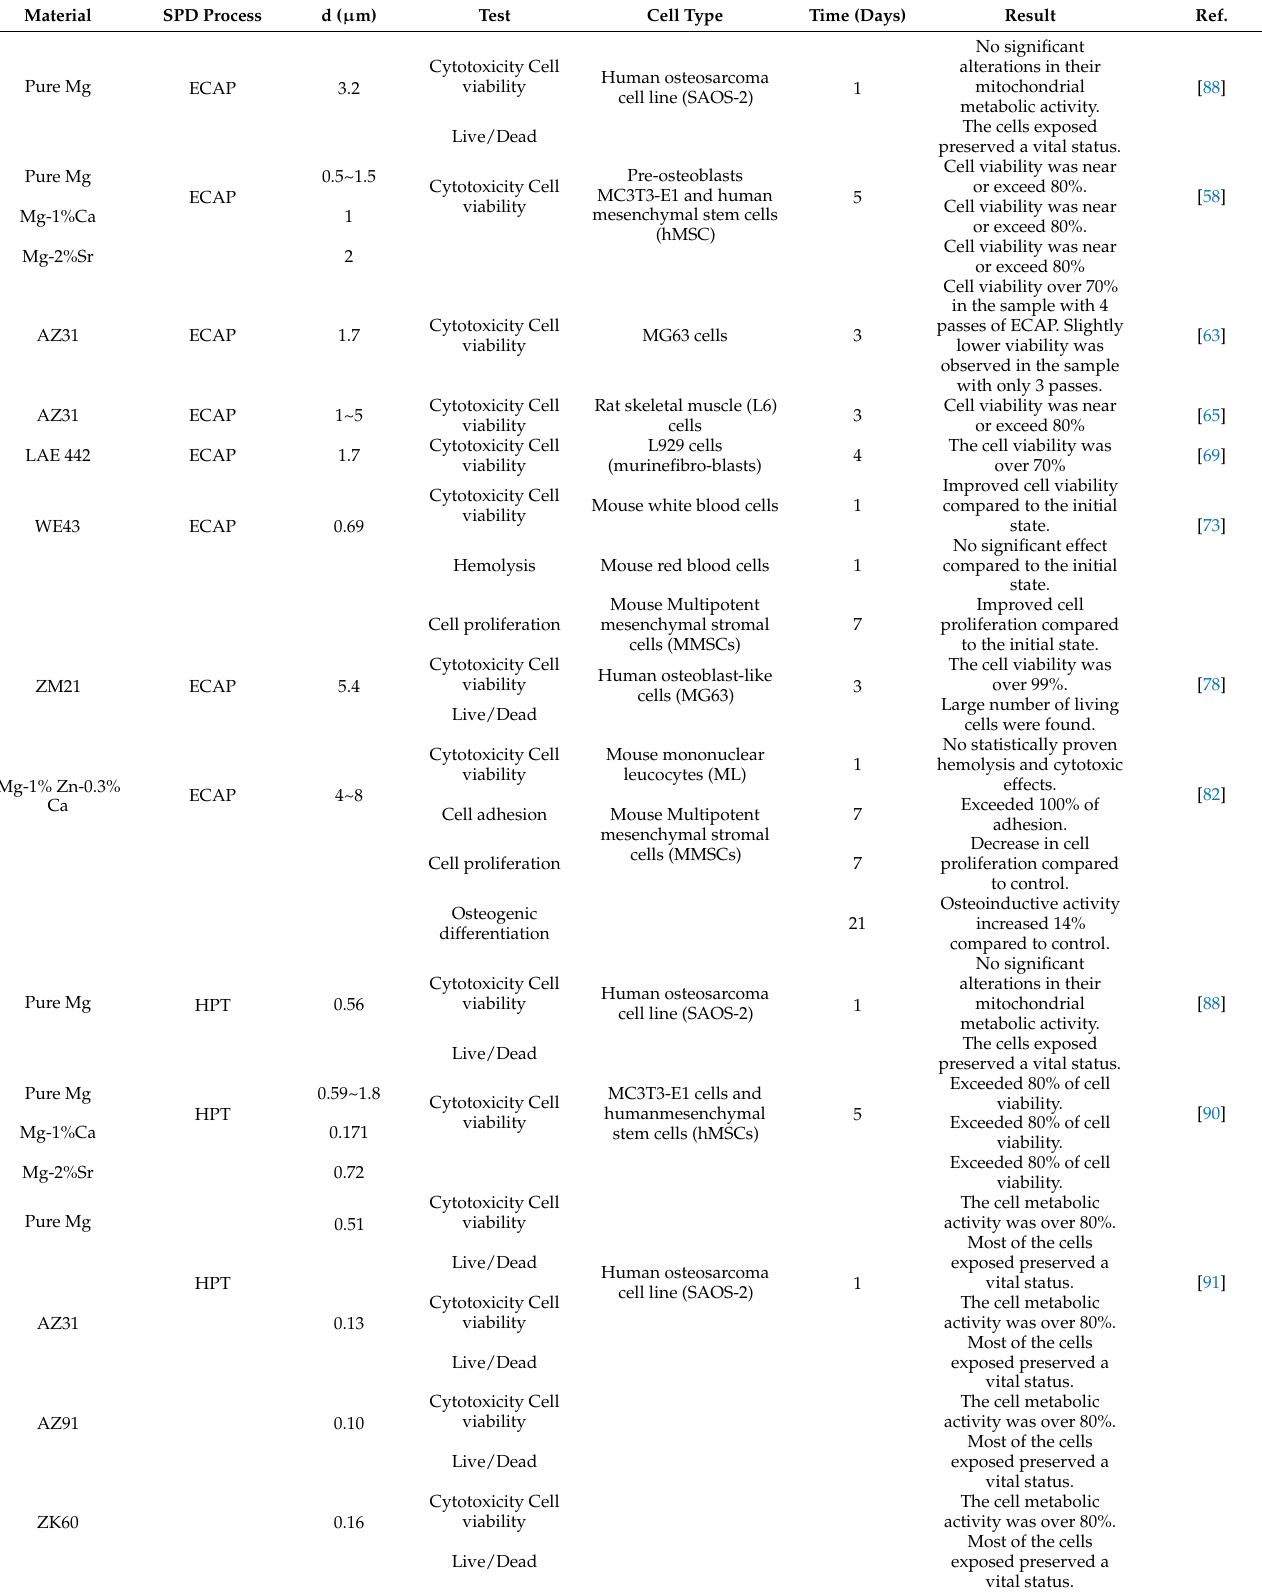
Table 2. Summary of in vitro tests of cytotoxicity carried out in Mg and Mg alloys processed via